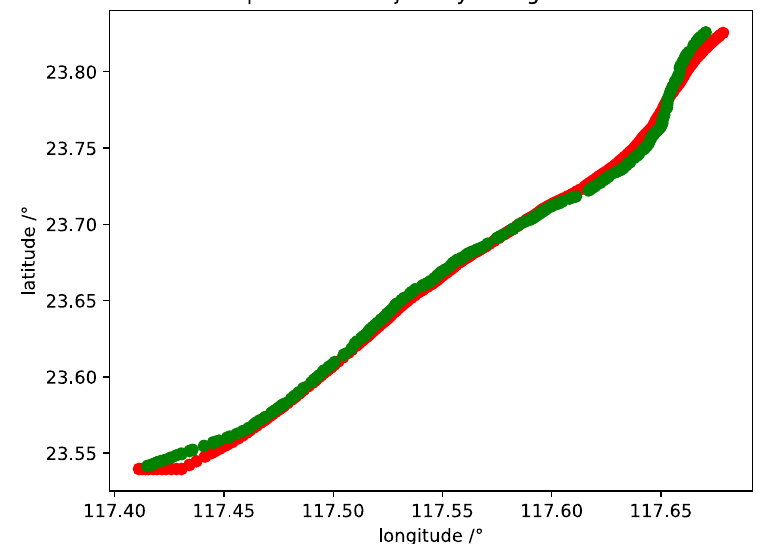
Sensors 2020 , 20 , x FOR PEER REVIEW Figure 16. Plot of comparison of prediction accuracy diagram of two models. Figure 16. Plot of comparison of prediction accuracy diagram of two models.